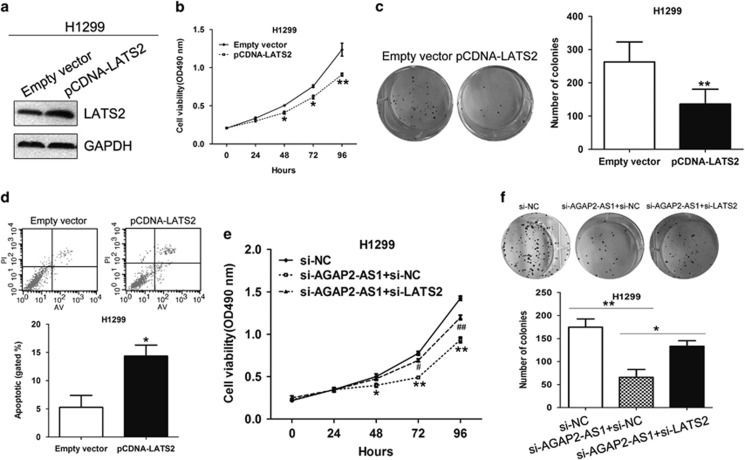
AGAP2-AS1 function as oncogene by repressing LATS2 expression in NSCLC cells. H1299 cells were transfected with pCDNA-LATS2 or co-transfected with si-AGAP2-AS1 and si-LATS2. (a) The protein level of LATS2 was detected by western blot in H1299 cell, which is transfected with pCDNA-LATS2 or empty vector. (b and c) MTT assays and colony-forming assays were used to determine the cell viability and cloning ability in pCDNA-LATS2- or empty vector-transfected H1299 cells. (d) Apoptosis was determined by flow cytometry in pCDNA-LATS2- or empty vector-transfected H1299 cells. LL, dead cells; UL, viable cells; LR, early apoptotic cells; UR, late apoptotic cells. (e and f) MTT assays and colony-forming assays were used to determine the cell viability and cloning ability in negative control siRNA, si-AGAP2-AS1- or siAGAP2-AS1- and si-KLF2-co-transfetced H1299 cells. Values represent the mean±S.E.M from three independent experiments. *P<0.05 and **P<0.01